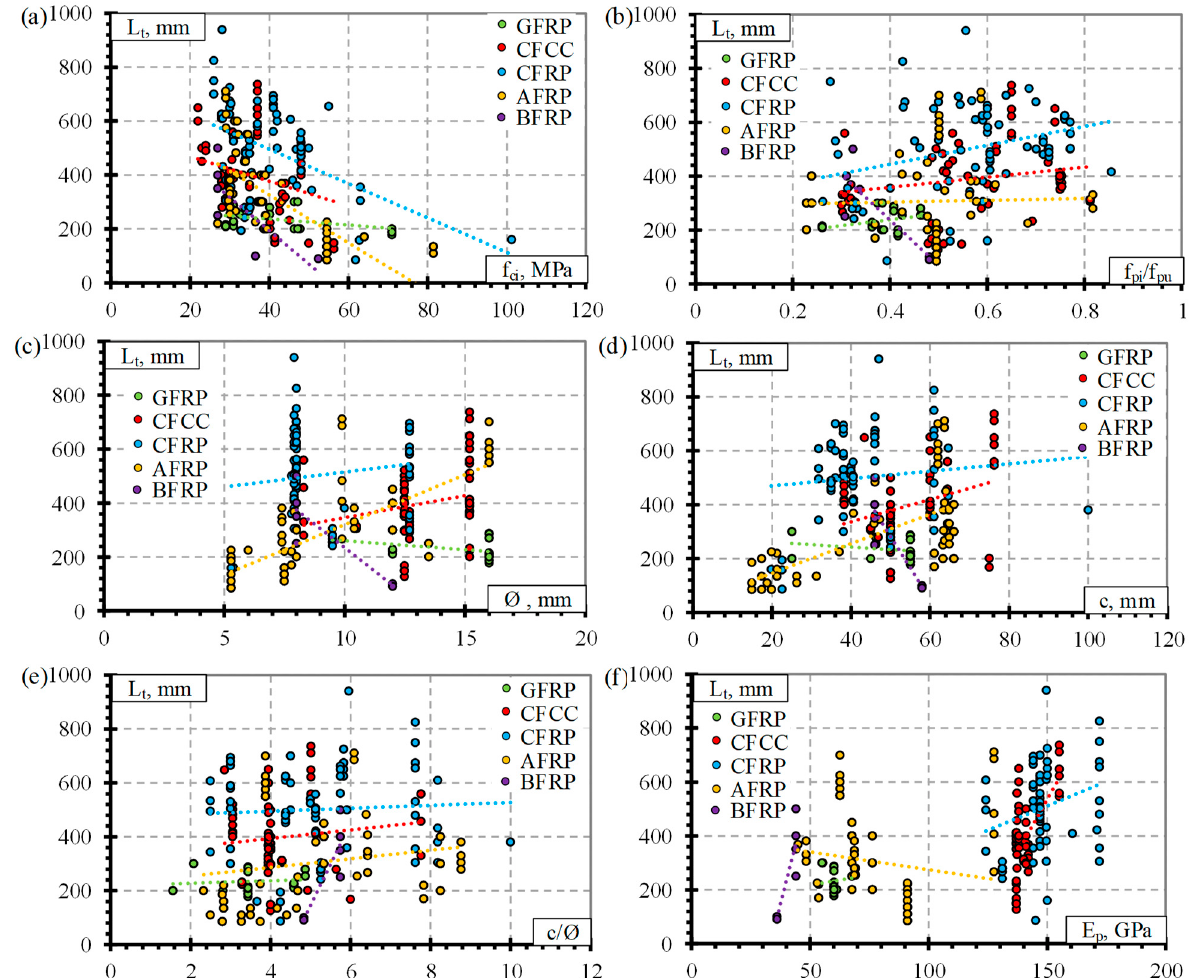
Figure 1. Relationship between transfer length and ( a ) concrete compressive strength at transfer (f ci ), ( b ) ratio between initial stress and tensile strength (f pi /f pu ), ( c ) reinforcement diameter (Ø), ( d ) concrete cover (c), ( e ) ratio between the concrete cover and reinforcement diameter (c/Ø), ( f ) modulus of elasticity (E p ) of different types of pretensioned FRP reinforcement.